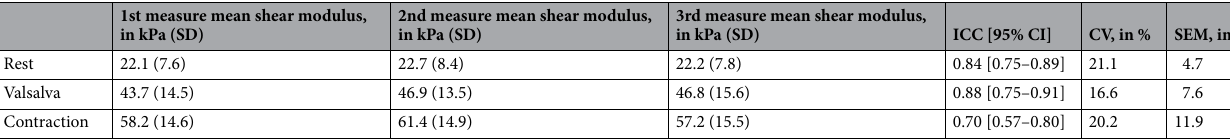
Table 2. Intrasession reproducibility performances for the assessment of the right levator ani muscle’s shear modulus with 3 consecutive measures. ICC: Intraclass correlation coefficient, CI: confidence interval, CV: coefficient of variation, SEM: standard error of